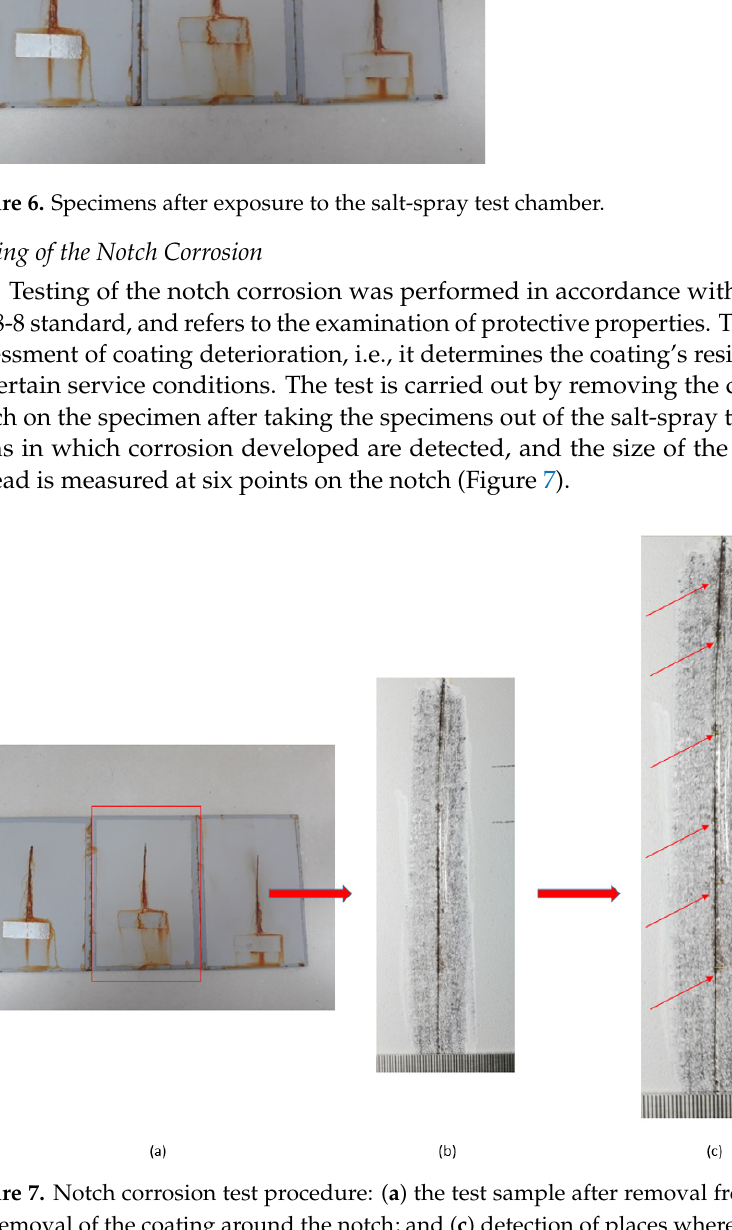
Figure 6. Specimens after exposure to the salt-spray test chamber.